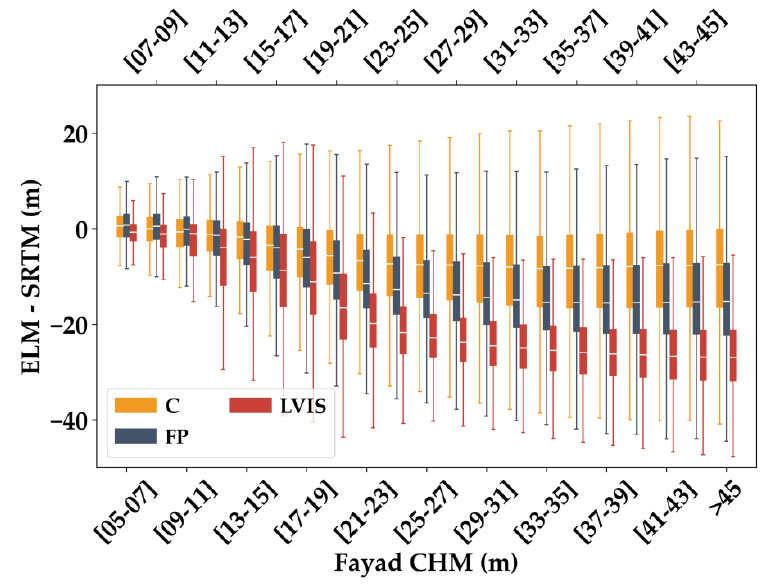
Figure 3. Boxplots of the difference between the elevation of each waveform’s lowest mode (ELM) and SRTM from GEDI’s coverage (C) and full-power (FP) lasers, as well as those from LVIS.